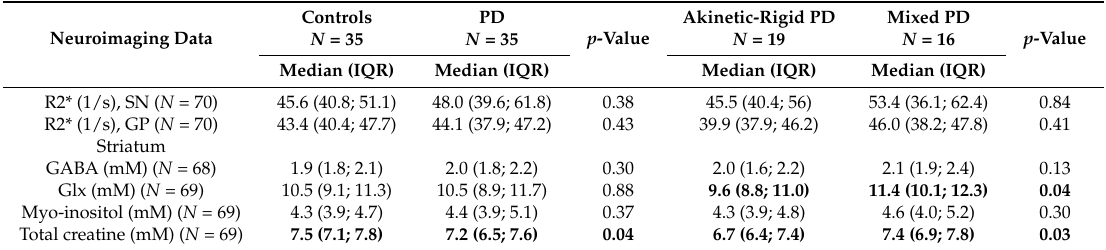
Table 2. Distribution of brain iron and neurometabolites in male Parkinson patients and controls. Neuroimaging